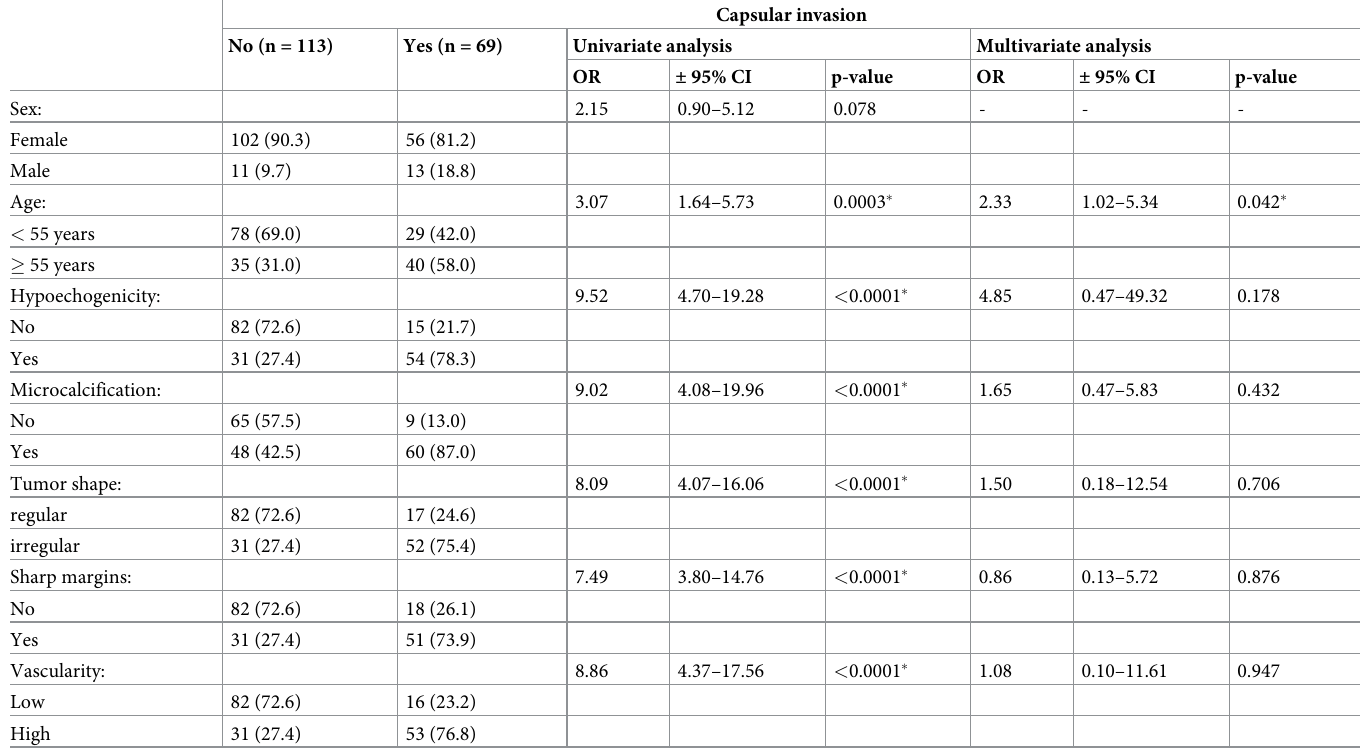
Table 3. Univariate and multivariate logistic regression analysis of demographic and ultrasound features as risk factors for capsular invasion in PTMC